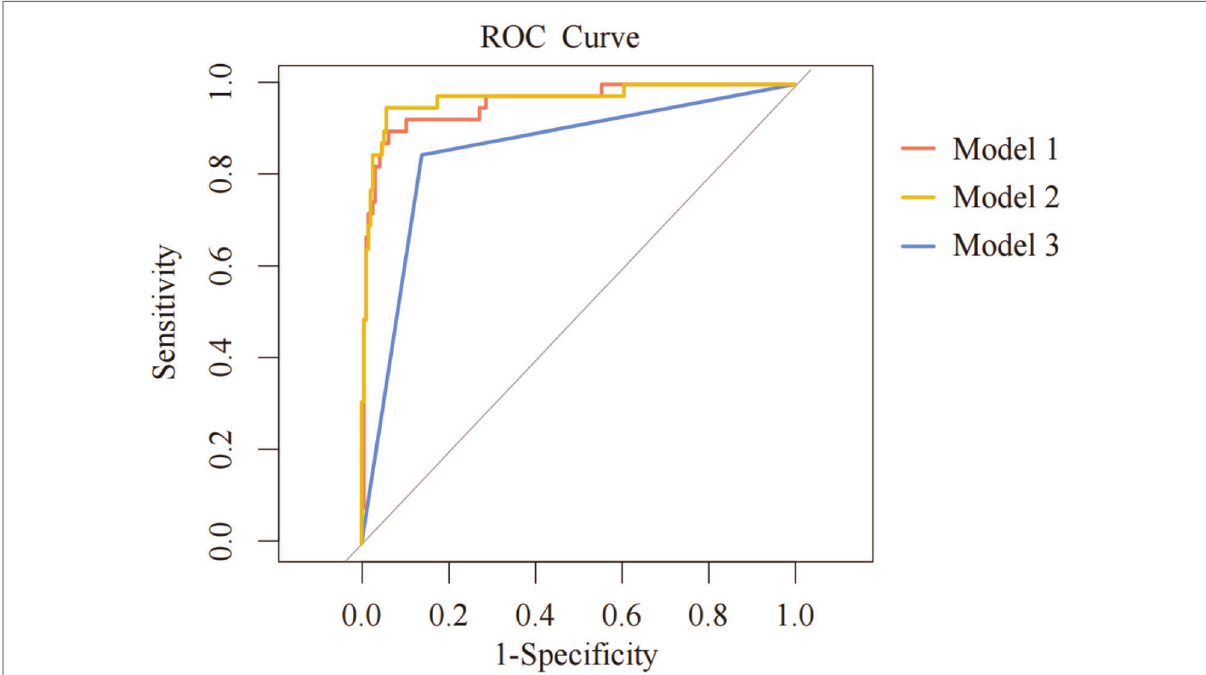
FIGURE 3 ROC curves for three models. ROC, receiver operator characteristics; AUC, area under the curve. The models are represented with curves in different colors. The dots on the curves are the optimal cutoffs. A larger AUC indicates that a model has greater capability to distinguish patients from non- patients and the prediction results are more accurate with better discrimination.